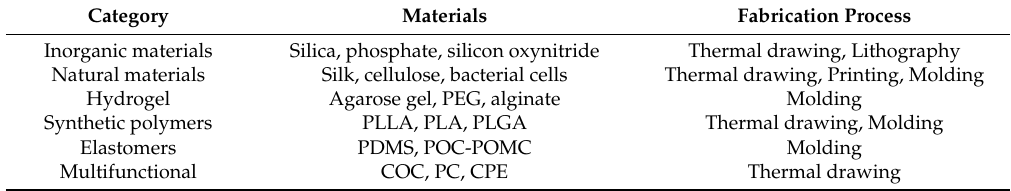
Table 1. A summary of representative materials and methods to form biocompatible fibers and